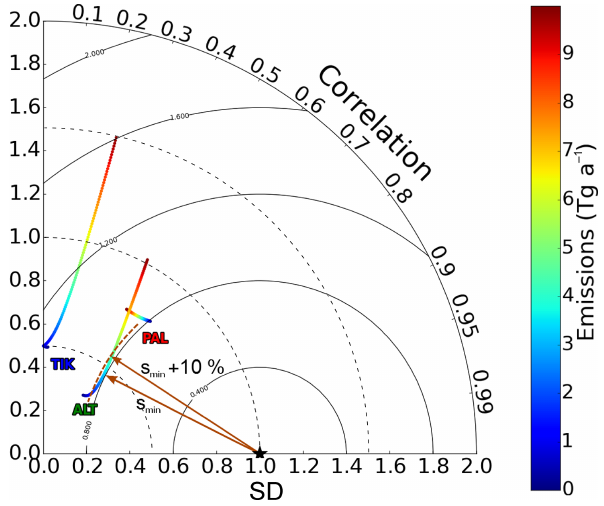
Figure 3. Taylor diagram representation of the statistical analysis of the ESAS emissions (see Sect. 2.4). For each observation site, ESAS emission scenarios from 0 to 10TgCH 4 yr − 1 are located on the Taylor diagram, depending on the compatibility (correlation and standard deviation) between observations and simulations, thus gen- erating a compatibility trajectory. The Taylor plot is based on a polar projection with the standard deviation as the radius and the corre- lation coefficient as the polar angle. Point colours depict the ESAS emission magnitude for each scenarios. To compare the different sites, each trajectory has been normalized by the site standard devi-